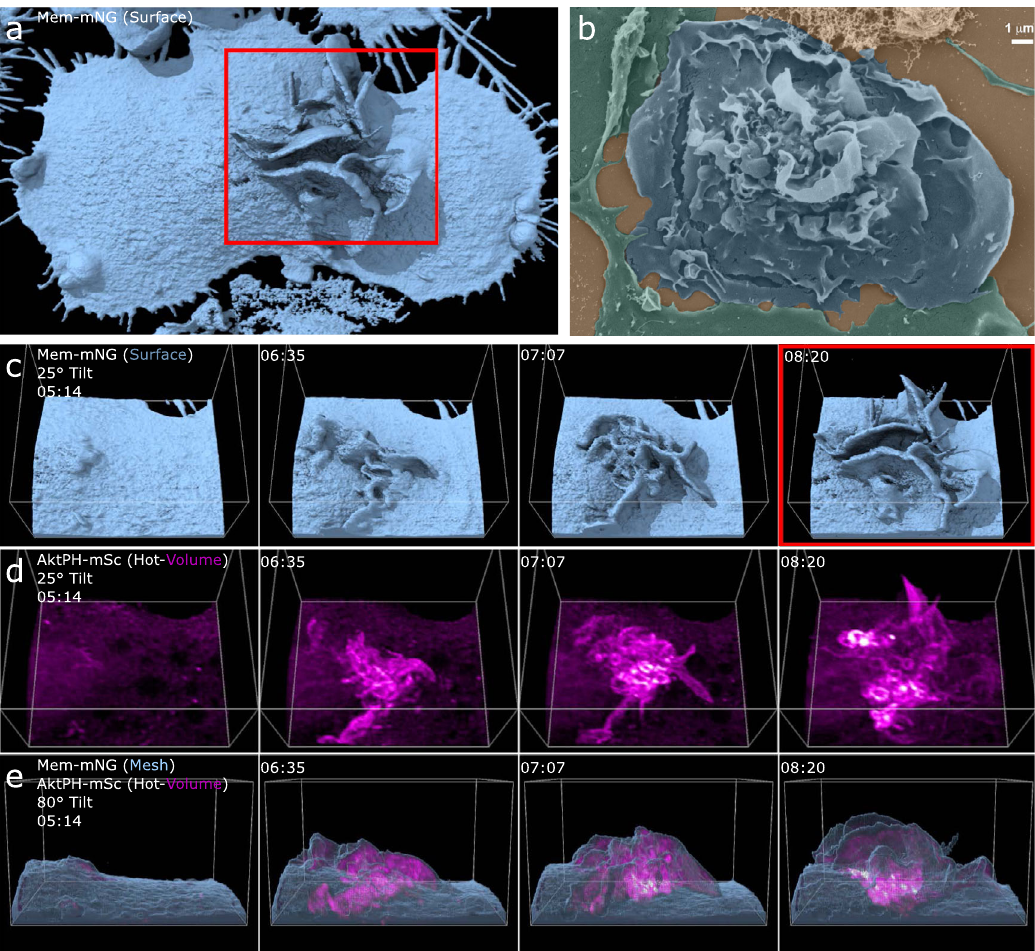
Fig. 5 Phosphatidylinositol localization and chaotic ruf fl ing underlie macropinocytosis in complex membrane structures. a Single time point, full cell surface rendering of chaotic macropinocytosis event. The red box correlates to the same frame in c , d . b SEM images of a BMDM showing similar highly active ruf fl ing regions. ( n = 10 micrographs, scale bar 1 µ m). c Isosurface montage shows the chaotic orientation of membrane structure (region 27 × 22